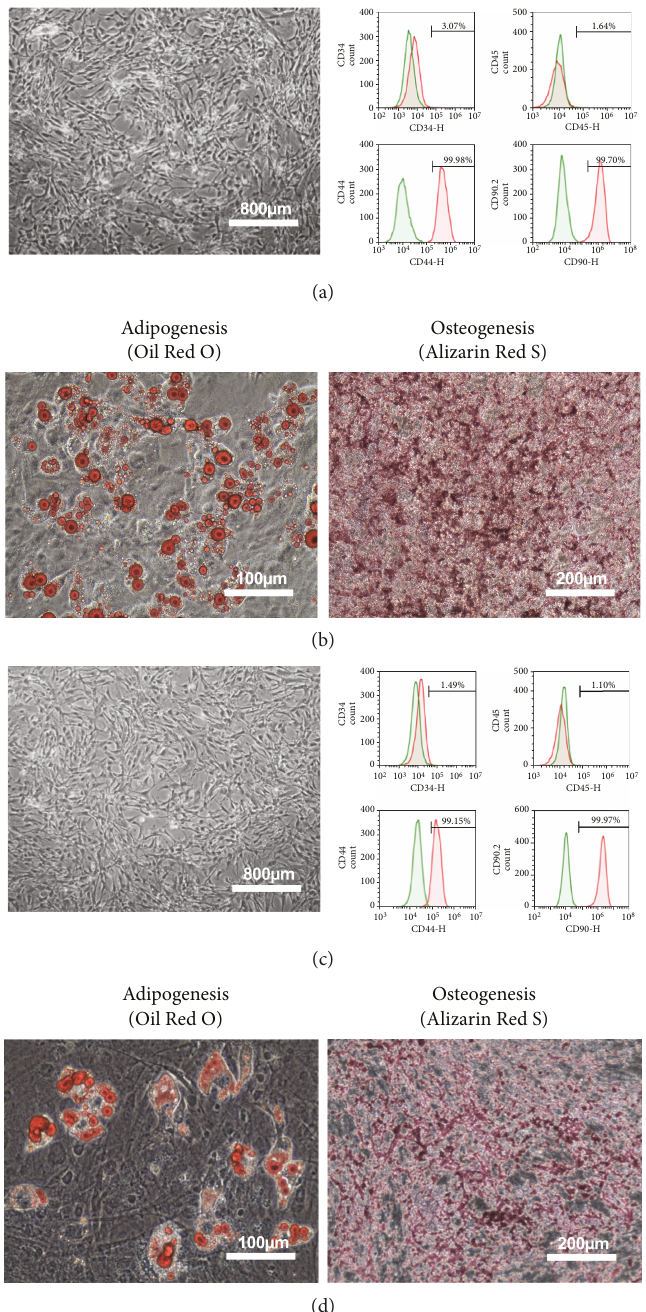
Figure 1: The phenotype and di ff erentiation potential of mMSC-ATs in culture. The morphological appearance of mMSC-ATs (P0) ((a) left panel; scale bar =800 μ m). The results of fl ow cytometry of the cell surface markers of mMSC-ATs (P0) ((a) right panels). Representative images of adipocyte ((b) left panel; scale bar =100 μ m) and osteocyte di ff erentiation ((b) right panel; scale bar =200 μ m) of mouse MSC- ATs (P0) cultured in di ff erentiation medium. The morphological appearance of mMSC-ATs (P3) ((c) left panel; scale bar =800 μ m). The results of fl ow cytometry of the cell surface markers of mMSC-ATs (P3) ((c) right panels). Representative images of adipocyte ((d) left panel; scale bar =100 μ m) and osteocyte di ff erentiation ((d) right panel; scale bar =200 μ m) of mouse MSC-ATs (P3) cultured in di ff erentiation